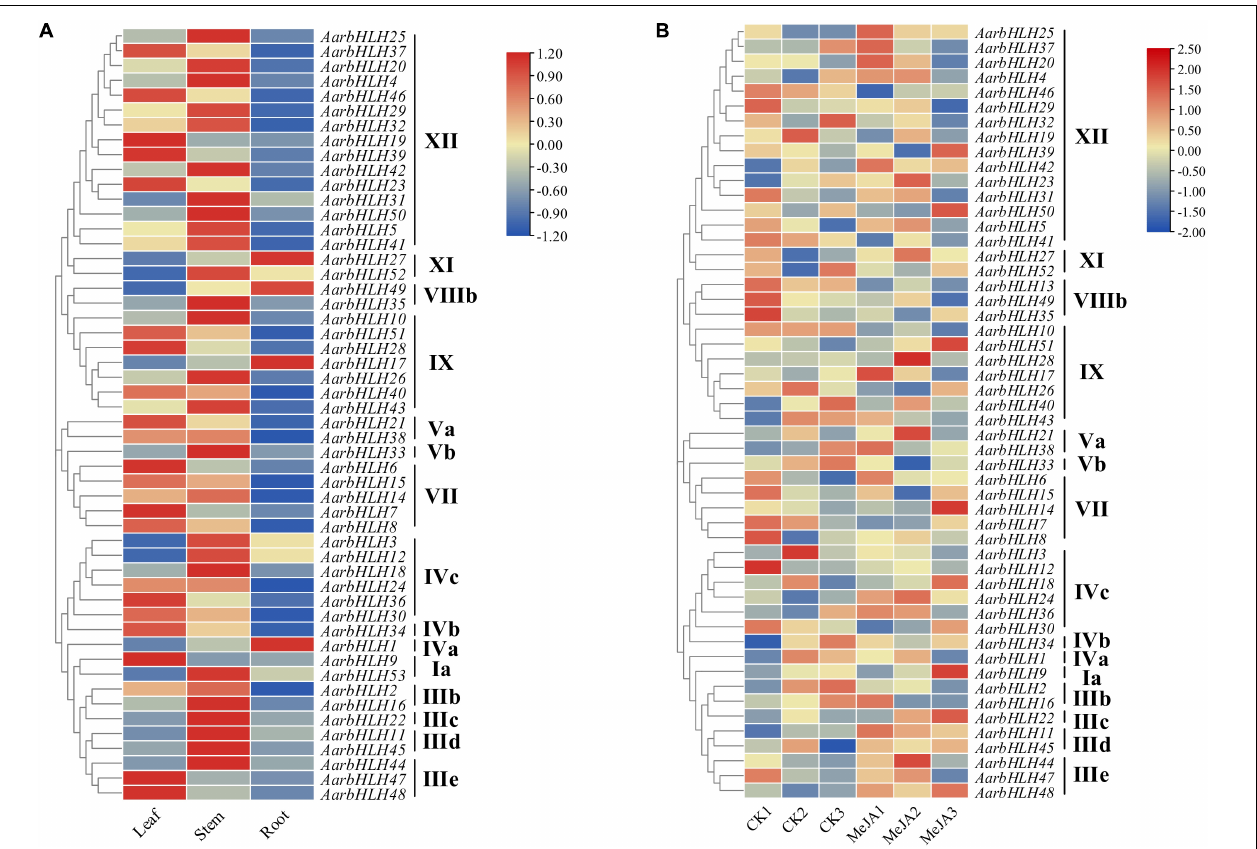
FIGURE 6 | The heat maps of gene expression of AarbHLHs in the LSR group and the MeJA group. (A) The heat map of AarbHLHs expression in the LSR group. (B) The heat map of AarbHLHs expression in the MeJA group.